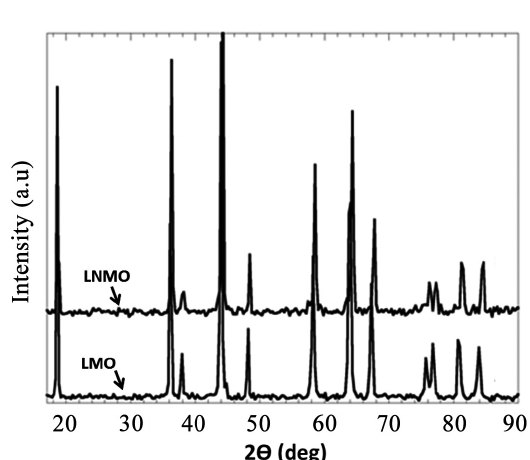
Figure 3 . TEM images of CNTs before (a) and after (b) acid treatment.